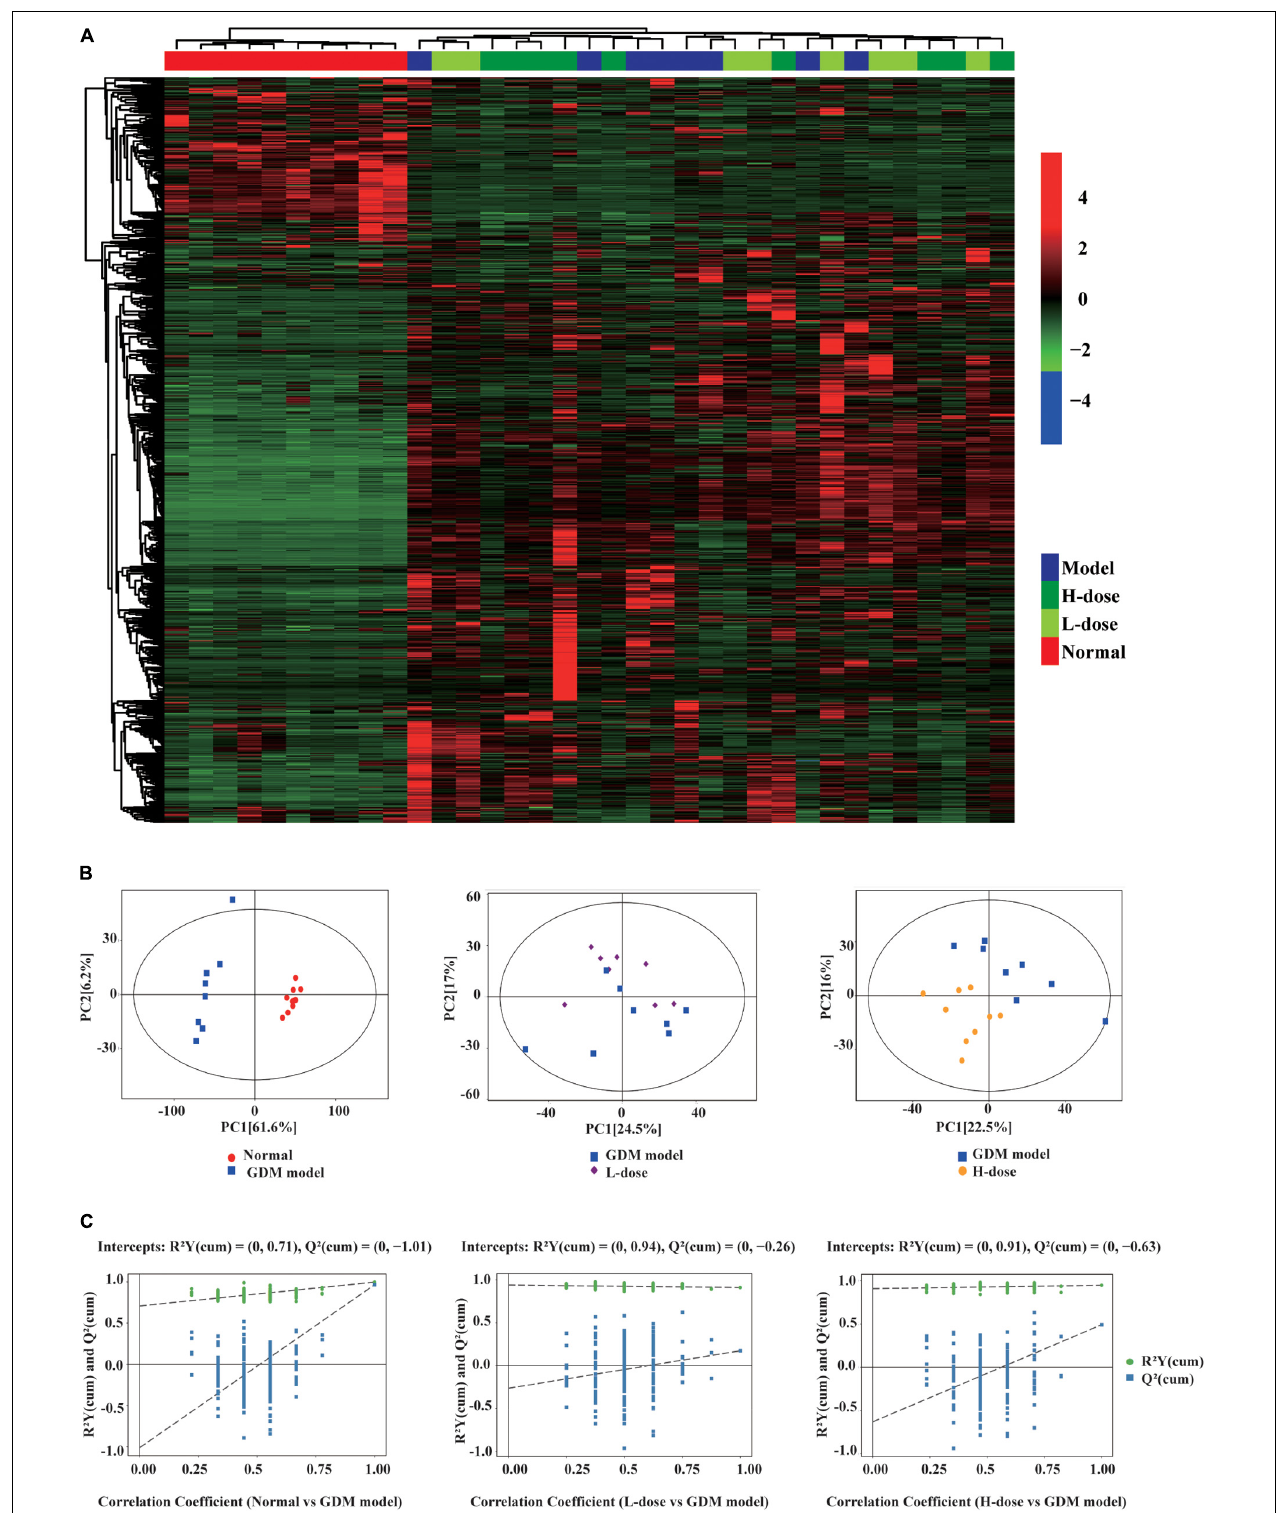
FIGURE 2 | The gut metabolites feature of GDM rats and GDM rats treated with probiotics. (A) Hierarchical clustering analysis of 999 metabolites in GDM rats and GDM rats treated with Lactobacillus and Bifidobacterium probiotics supplements. The OPLS-DA analysis (B) and the OPLS-DA permutation test (C) of the gut metabolites in GDM rats and GDM rats treated with probiotics supplements.